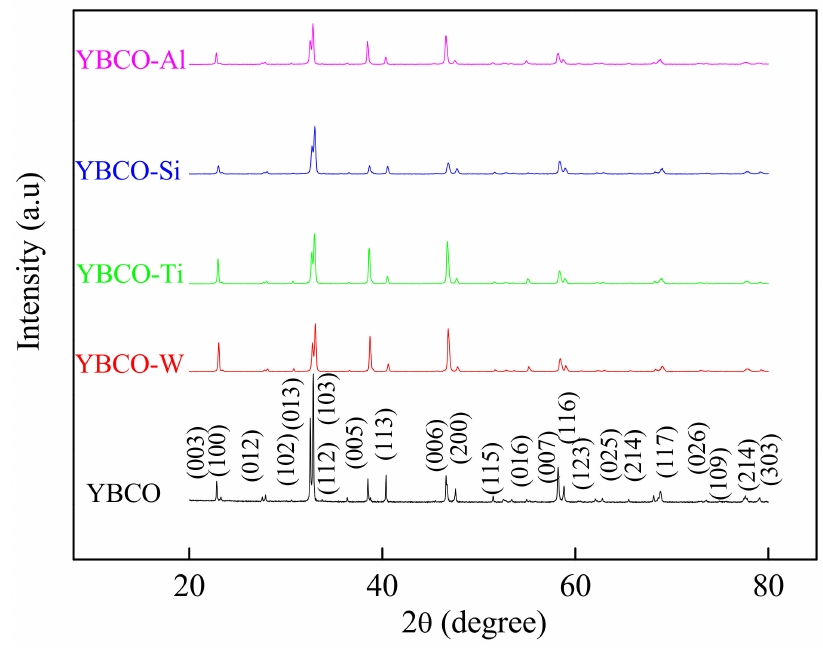
Figure 1. XRD patterns of YBCO, YBCO-W, YBCO-Ti, YBCO-Si, and YBCO-Al